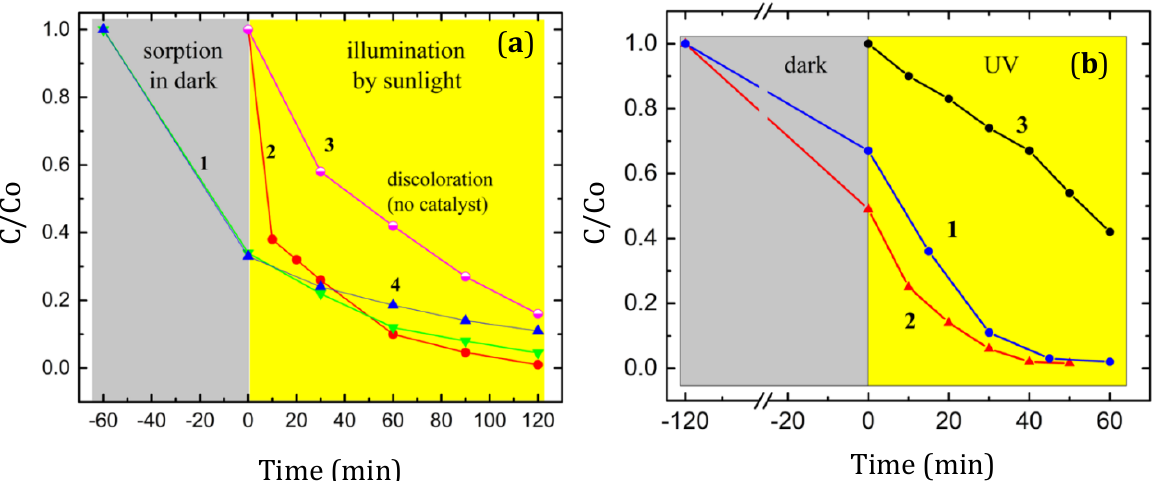
Figure 8. Time-dependences of the normalized absorbance of MB solutions (0.5 mg MB in 50 mL H 2 O) containing 10 mg of BNO 1 under sunlight illumination at 80 °C after 1 h of sorption in the dark (curve 1) and without sorption in the dark (curve 2). For comparison, the discoloration of the MB solution without a catalyst is shown (curve 3). Curve 4 shows the photocatalytic degradation of the solution under visible light illumination ( a ). Time-dependences of the normalized absorbance of MB solutions (0.5 mg MB in 50 mL H 2 O) containing 5 mg of BNO 1 (curve 1) and 5 mg of BNO 2 (curve 2) under UV illumination at 80 °C after 2 h of sorption in the dark ( b ). Curve 3 shows the discoloration of the MB solution under UV irradiation without a catalyst.